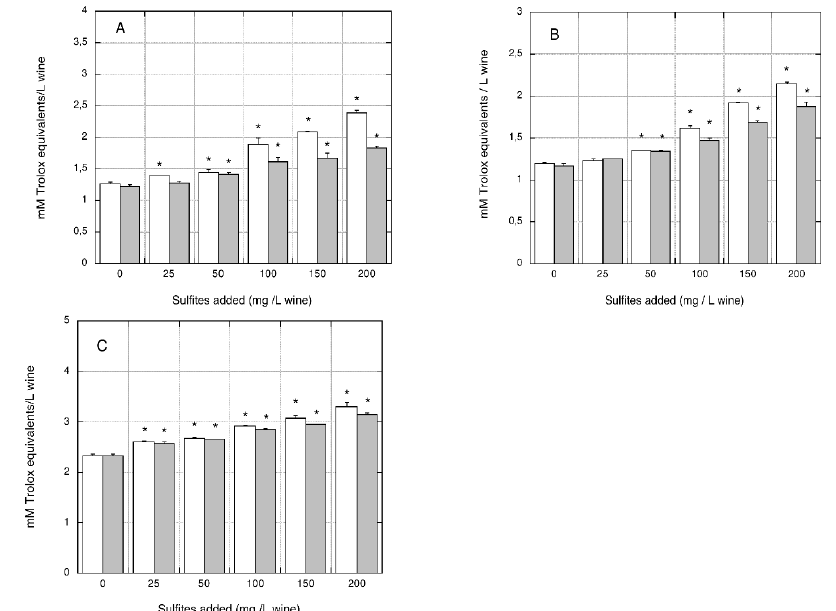
Figure 5. Effect of sulfite/metabisulfite addition to organic white wines on antioxidant activity measured with the FRAP assay. The FRAP assay was performed using ferrous sulfate for the calibration curve. ( A ) AO organic wine; ( B ) BO organic wine; ( C ) CO organic wine. Closed grey bars: sodium sulfite addition. Open white bars: sodium metabisulfite addition. Data are means of four replicates ± SE. * p < 0.05 relative to control, without sulfite/metabisulfite addition, by Student t -test.